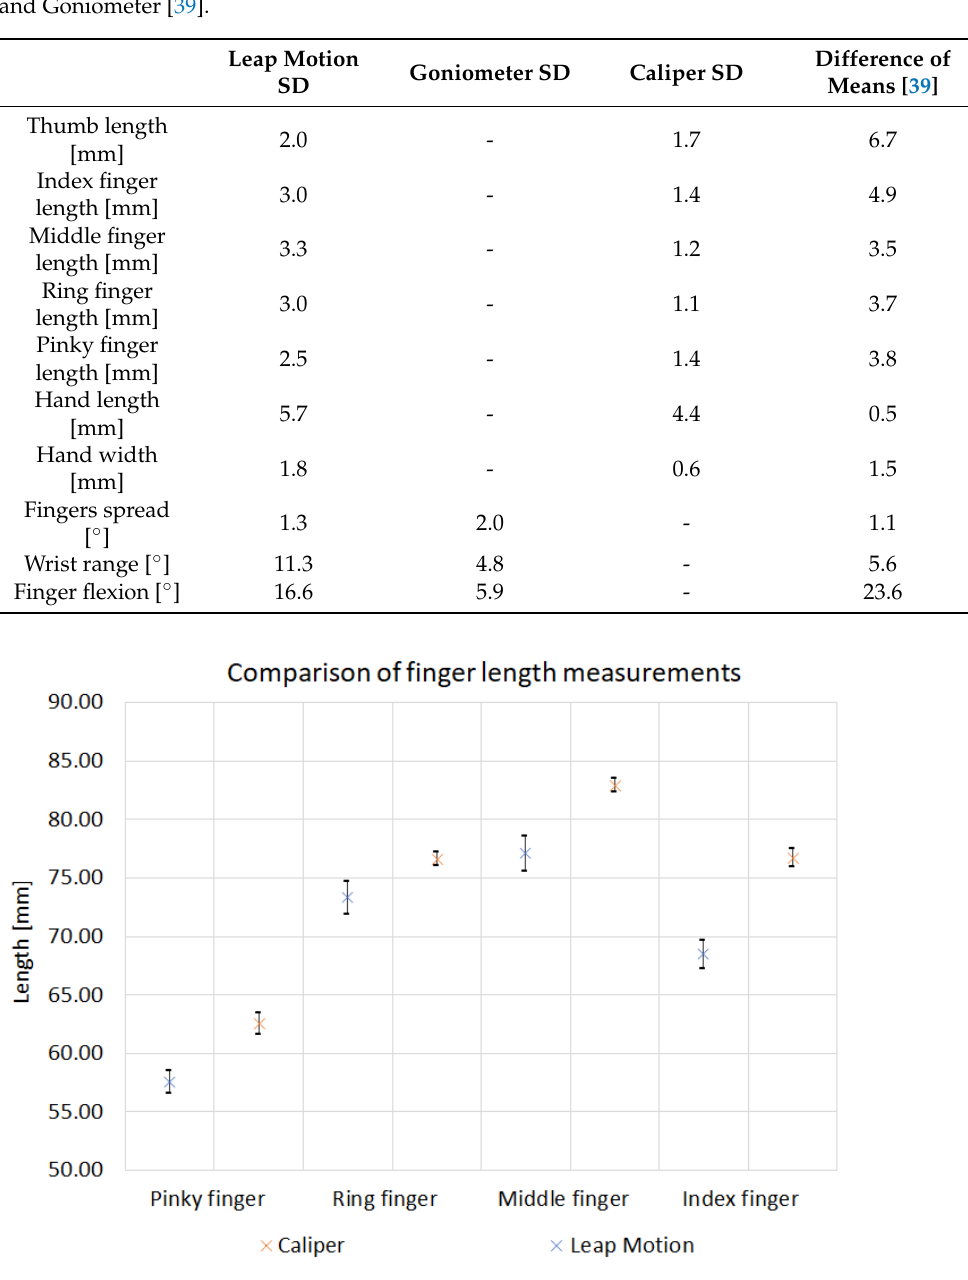
Figure 10. Comparison of finger length measurement by Leap Motion and